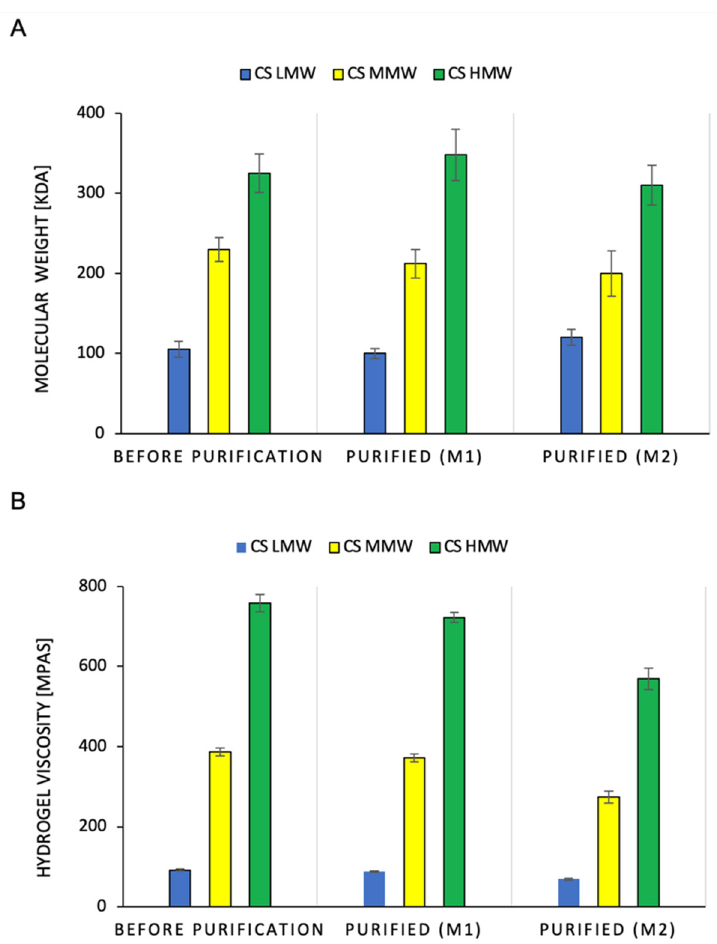
Figure 3. Comparison of molecular weight of chitosan polymer ( A ) and chitosan hydrogel. viscosity ( B ) with LMW, MMW and HMW, before and after purification using M1 or M2 method ( n = 3, p < 0.05).